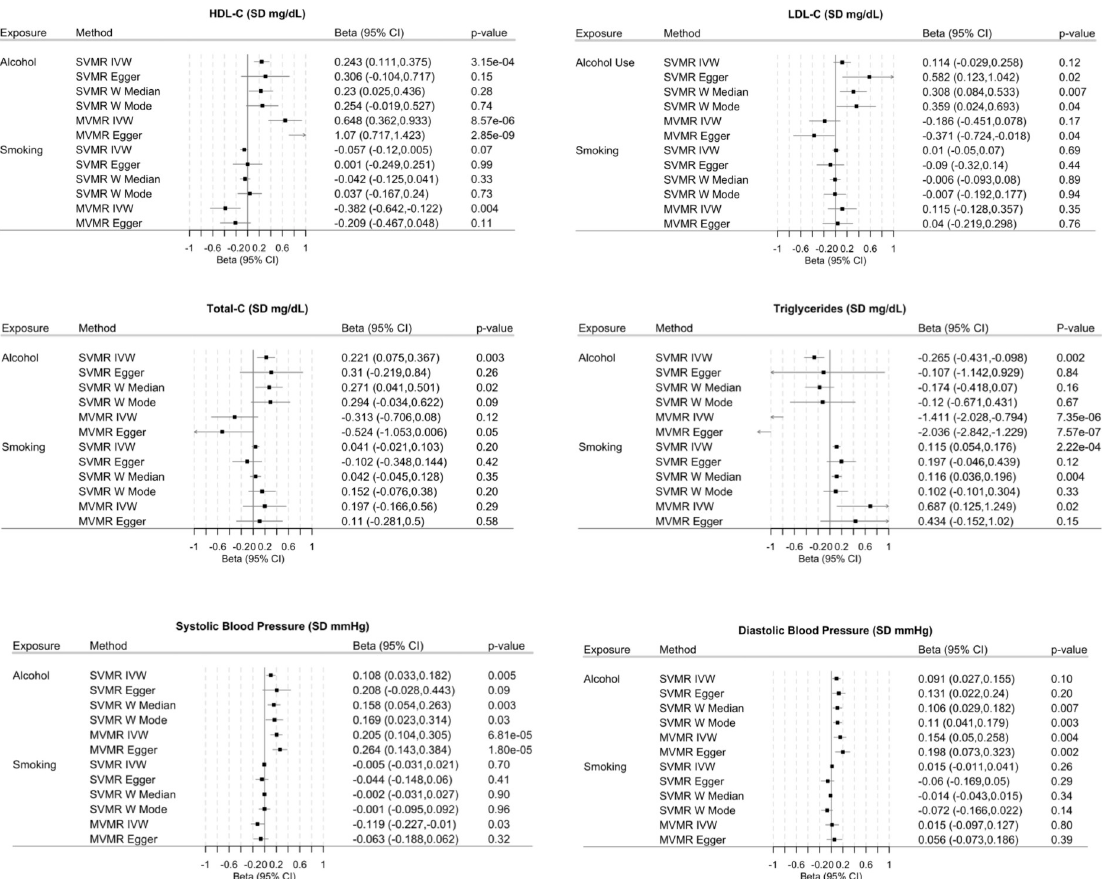
Fig 2. Associations of genetically predicted alcohol consumption and smoking with CVD risk factors. For alcohol, estimates are expressed per 1 SD increase in log-transformed weekly alcohol drinks consumed (MVMR adjusts for smoking). For smoking, estimates are expressed per 1 SD increase in the log odds of smoking regularly (MVMR adjusts for alcohol consumption). CI, confidence interval; CVD, cardiovascular disease; HDL-C, high-density lipoprotein cholesterol; IVW, inverse variance weighted; LDL-C, low-density lipoprotein cholesterol; MVMR, multivariable Mendelian randomization; SD, standard deviation; SNP, single nucleotide polymorphism.